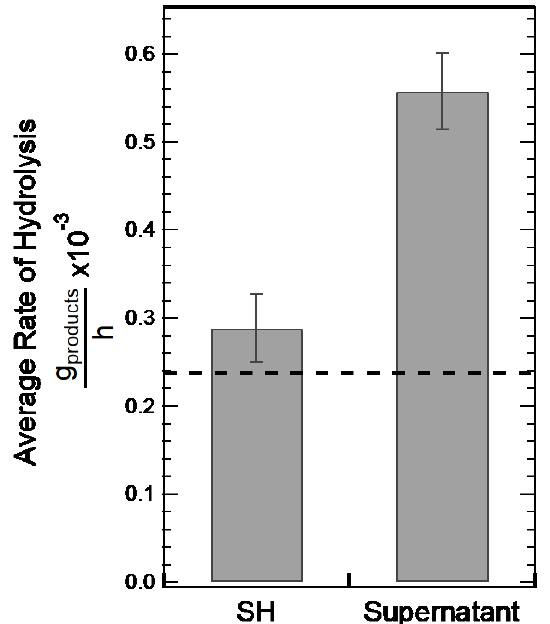
Figure 6. Comparison of average product formation rate after hydrolysis of ball-milled cellulose with hydrothermally pretreated SH solid catalyst and its supernatant. The supernatant was generated as previously described. The dotted line represents the hydrolysis activity of water. Conditions: 150 ◦ C ( ± 2.5 ◦ C) reaction temperature 15 h reaction time, 2 mL of water, 0.1 g of cellulose, and 0.2 g of catalyst.